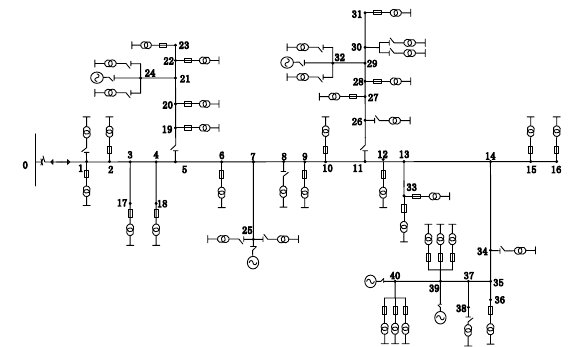
Fig. 10 Single-line diagram of the real power system